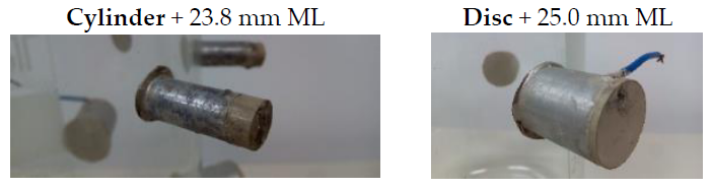
Figure 12. Aluminum matching layer attached to the glued ceramics for cylinders and discs.